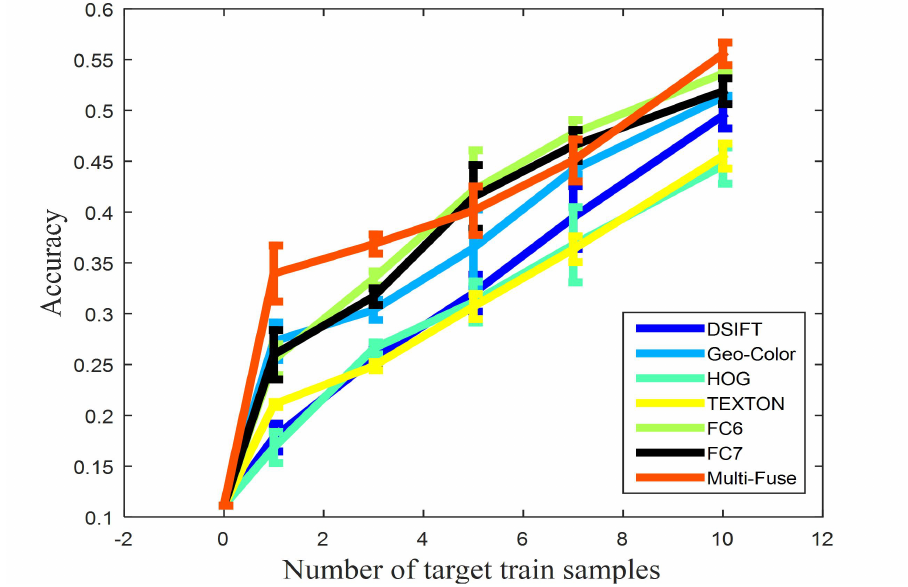
Figure 12. The performance (mean and standard deviation of overall accuracy) of our approach using different features with respect to different numbers of target samples per class for the aerial-to-satellite transfer task. Table 4. Per-class mAPs of different features with 10 target positive examples for all nine categories.